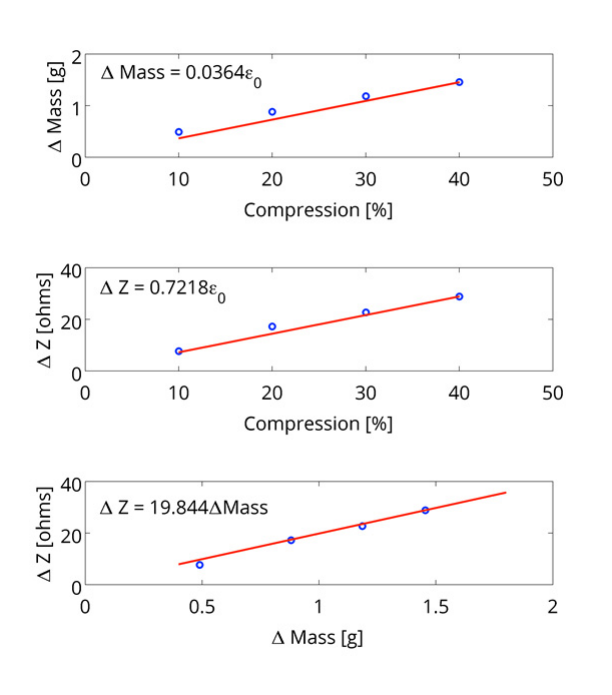
Fig. 4. The relationship between the change in mass ( Δ Mass), the change in impedance ( Δ Z), and the compression ( ε 0 ) were found to be linear ( R 2 > 0.95) across all samples indicating that the change in impedance is linked with the fluid exiting the sample, which in turn is a function of compression. The values reported here were found by taking the initial and final masses and impedances of the